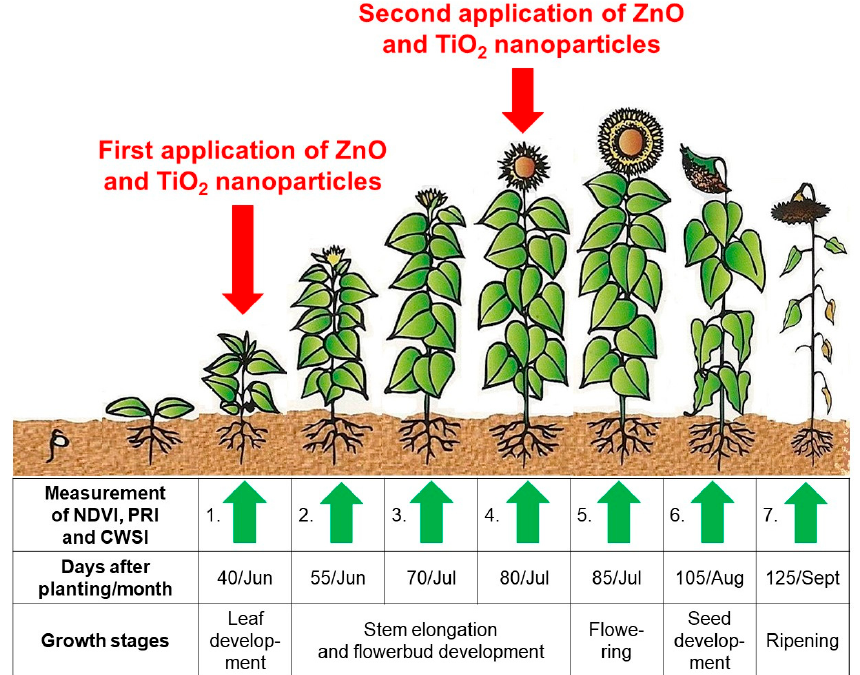
Figure 2. Schematic model of sunflower growth stages. While the red arrows indicate the foliar application of TiO 2 -NPs or ZnO-NPs, the green arrows indicate time intervals for measuring physiological parameters; normalised difference vegetation index (NDVI), photochemical reflectance index (PRI) and crop water stress index (CWSI) for the assessment of sunflower development.